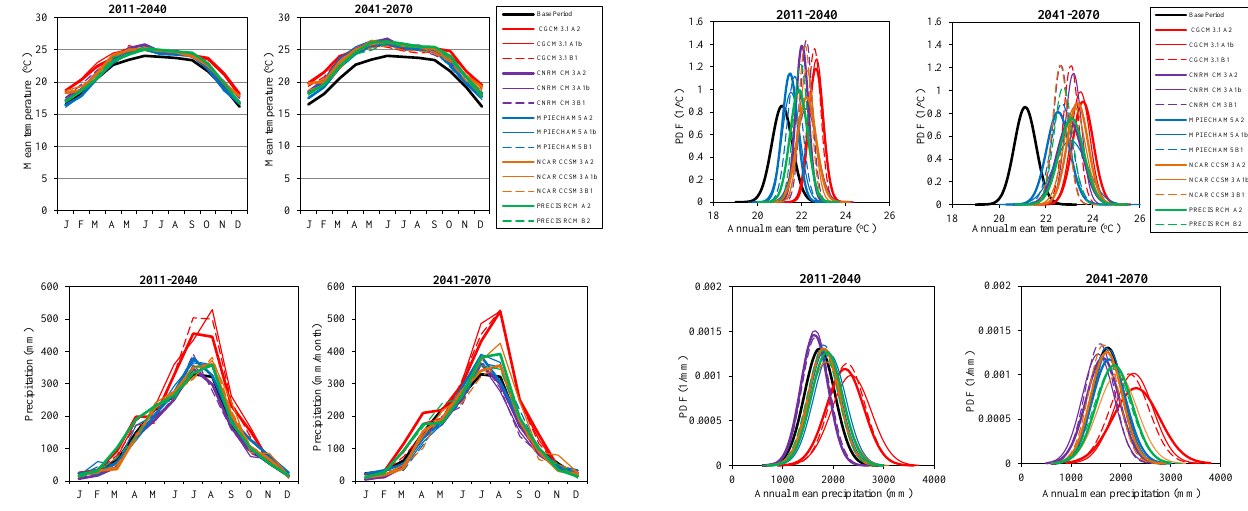
Fig. 5. Monthly temperature and precipitation averaged for all cli- mate projections for the 2011–2040, 2041–2070 periods and for the base period 1971–2000 for the Nam Ou basin.